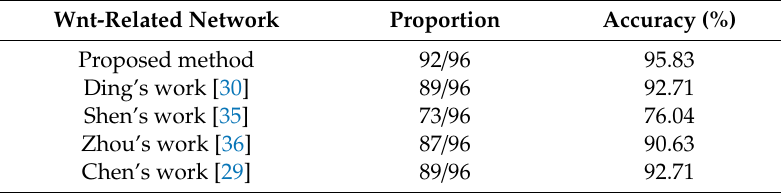
Table 4. Comparison of di ff erent methods on the Wnt-related network using yeast data set as the training data